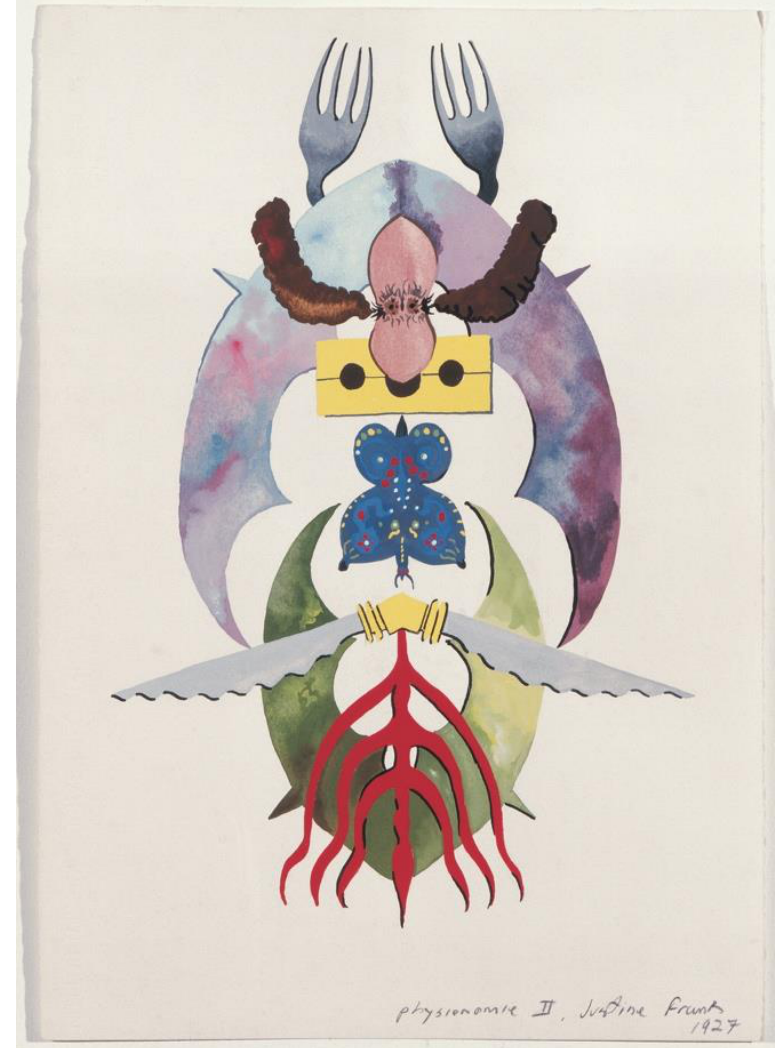
Figure 25. Justine Frank, Physionomie II , 1927, gouache on paper, 50 × 35 cm. Courtesy of the artist.